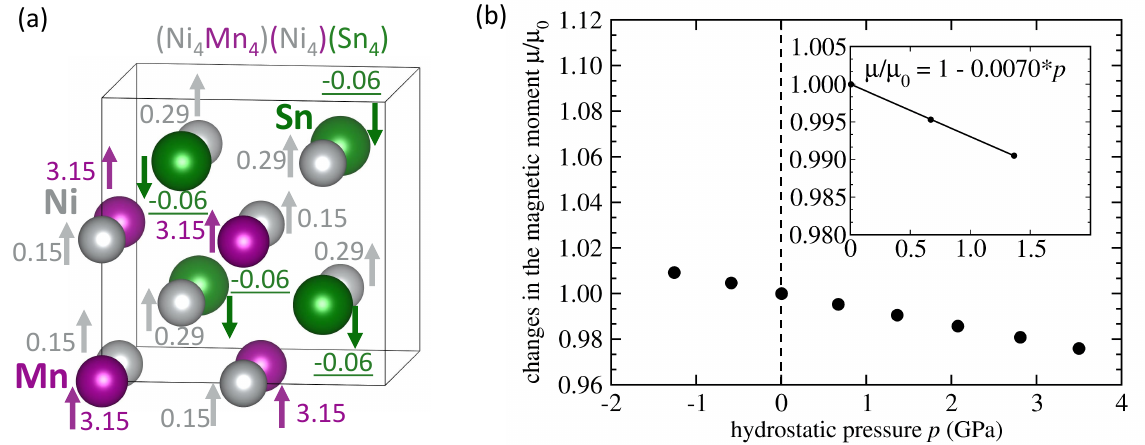
Figure 6. A 16-atom computational supercell of the stoichiometric Ni 2 MnSn with the inverse Heusler structure ( a ) and local magnetic moments corresponding to a minimum-energy zero-pressure state. Part ( b ) shows calculated pressure-induced changes of the total magnetic moment of the state shown in part ( a ) together with the corresponding linear fit.